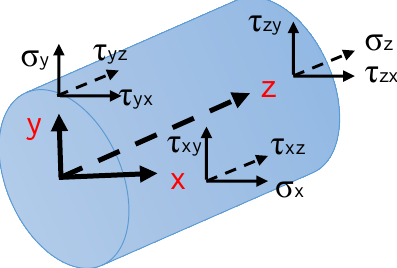
Figure 1. Diagram of stress decomposition.